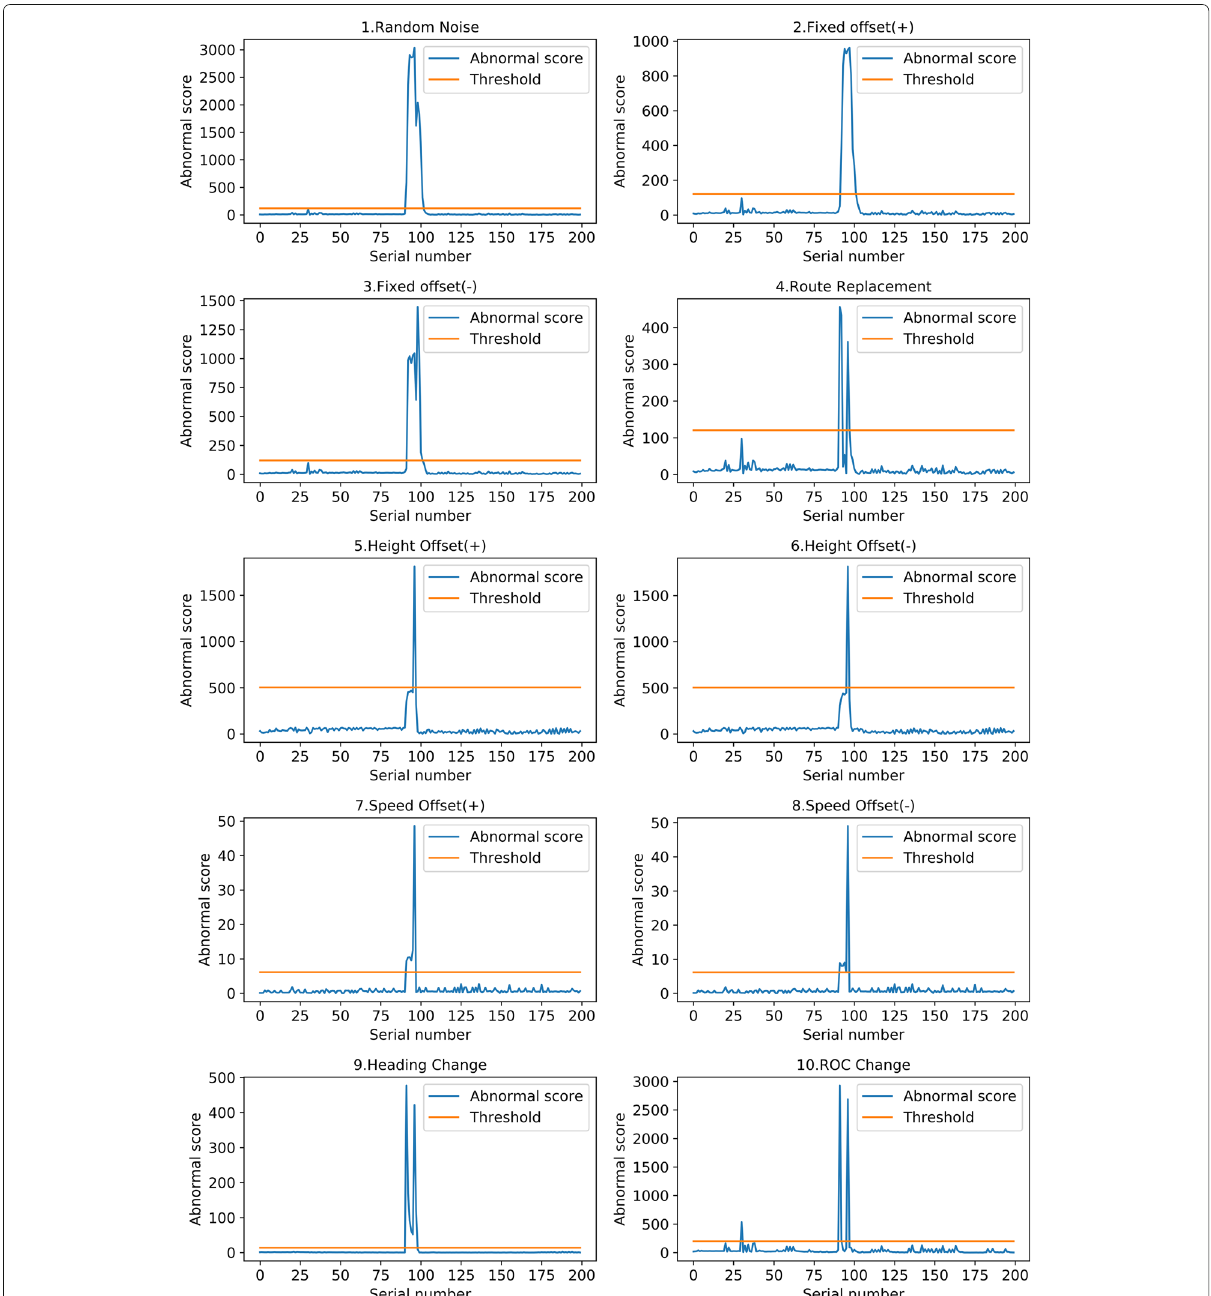
Fig. 7 Abnormal score figures. Abnormal score figures of different kinds of attack data where the abscissa is the data serial number and the ordinate is the abnormal score